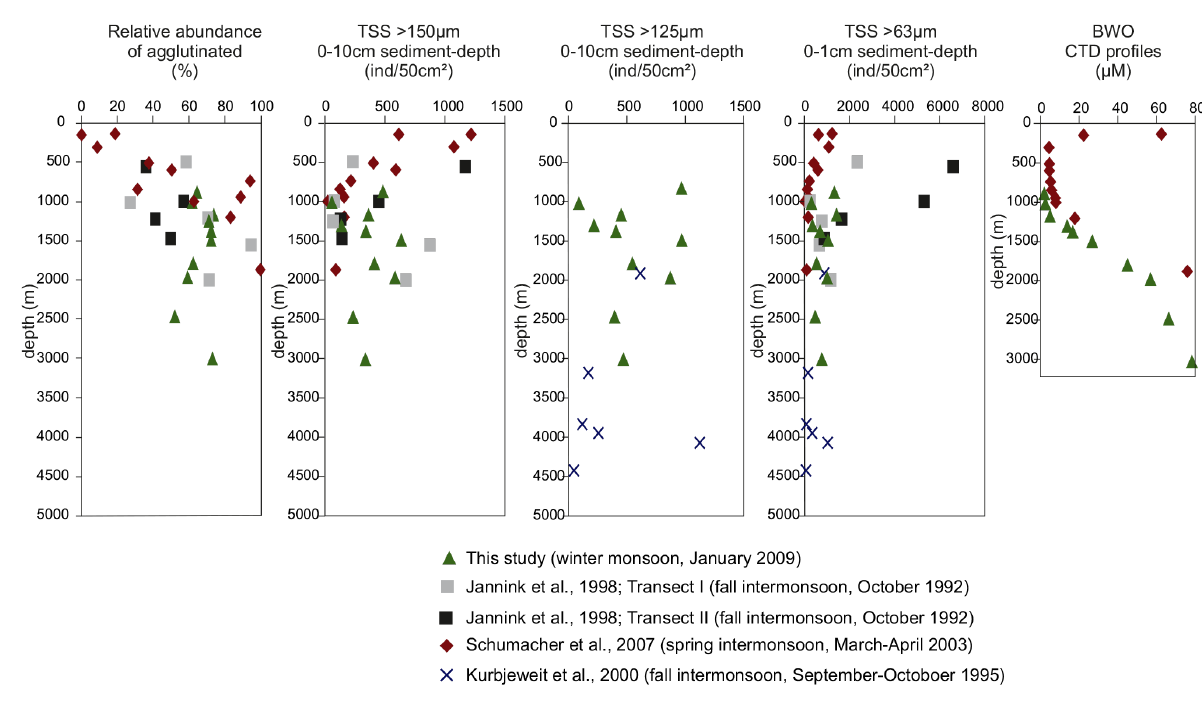
Fig. 8. Comparison of relative abundance of agglutinated faunas, foraminiferal abundances (ind/50cm 2 ) and BWO between our data and previous studies on the Arabian Sea (Jannink et al., 1998; Kurbjeweit et al., 2000; Schumacher et al., 2007). Note the scale